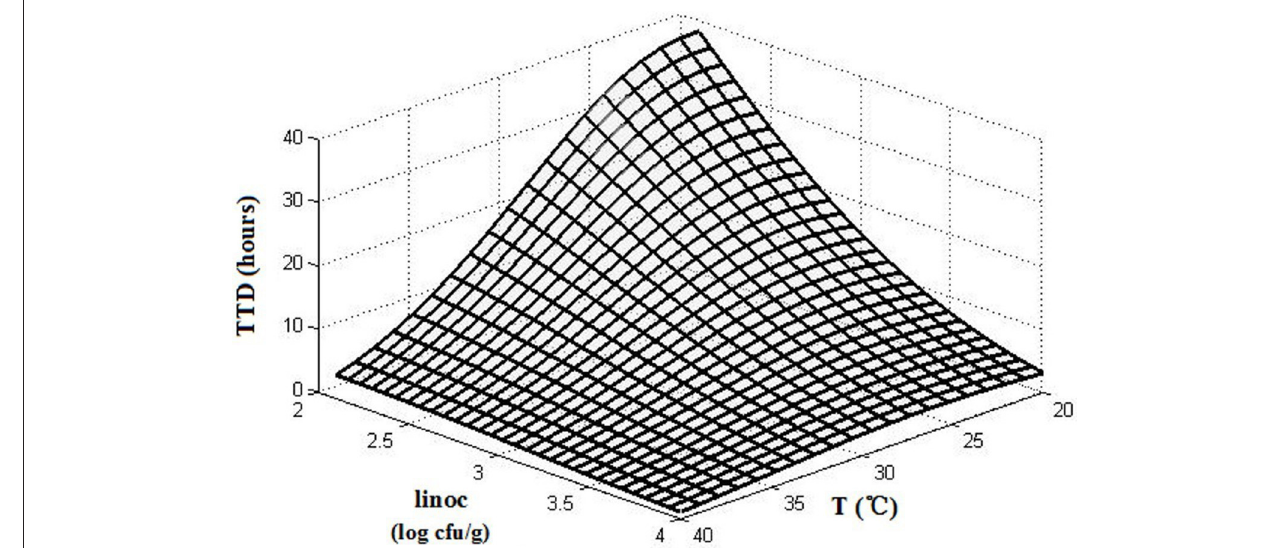
FIGURE 3 | The 3D surface plots of TTD affected by temperature (T) and initial inoculation level (linoc).